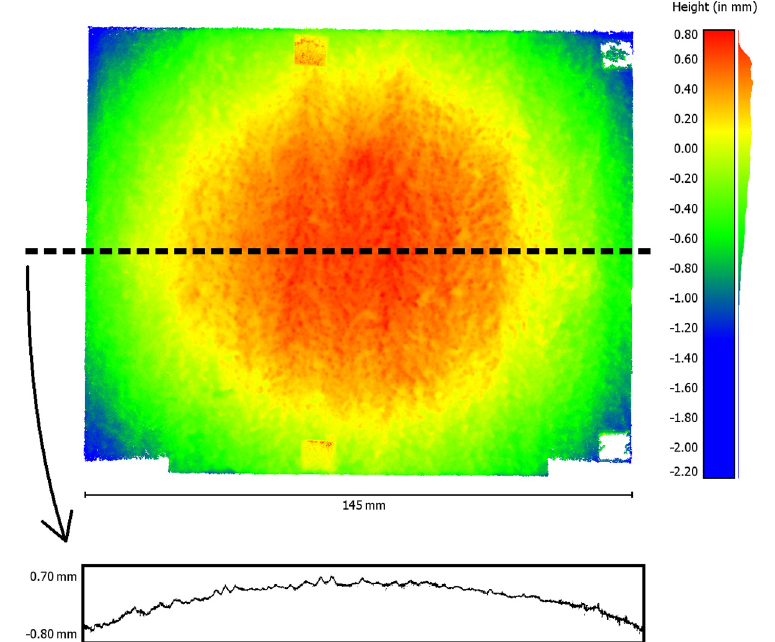
Figure 12. Reconstructed point cloud with conspicuous curvature after self-calibration (top, left), extracted profile line (bottom, 10-fold scaled in height), and histogram of the height values (right).